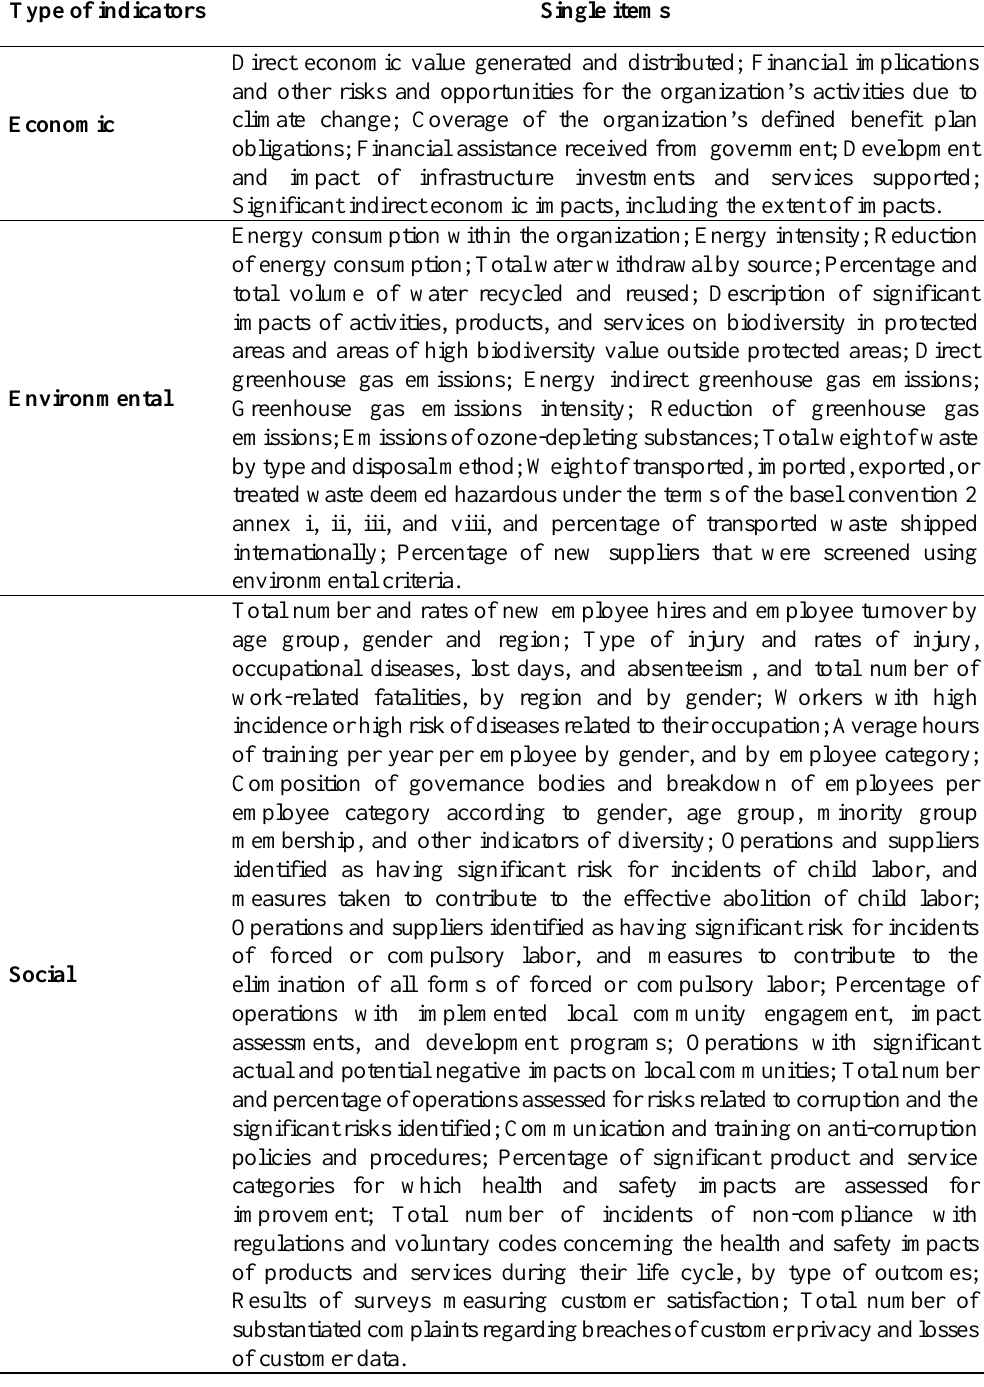
Table 1: Items Identified to Analyse the Type of Contents Available Type of indicators Single